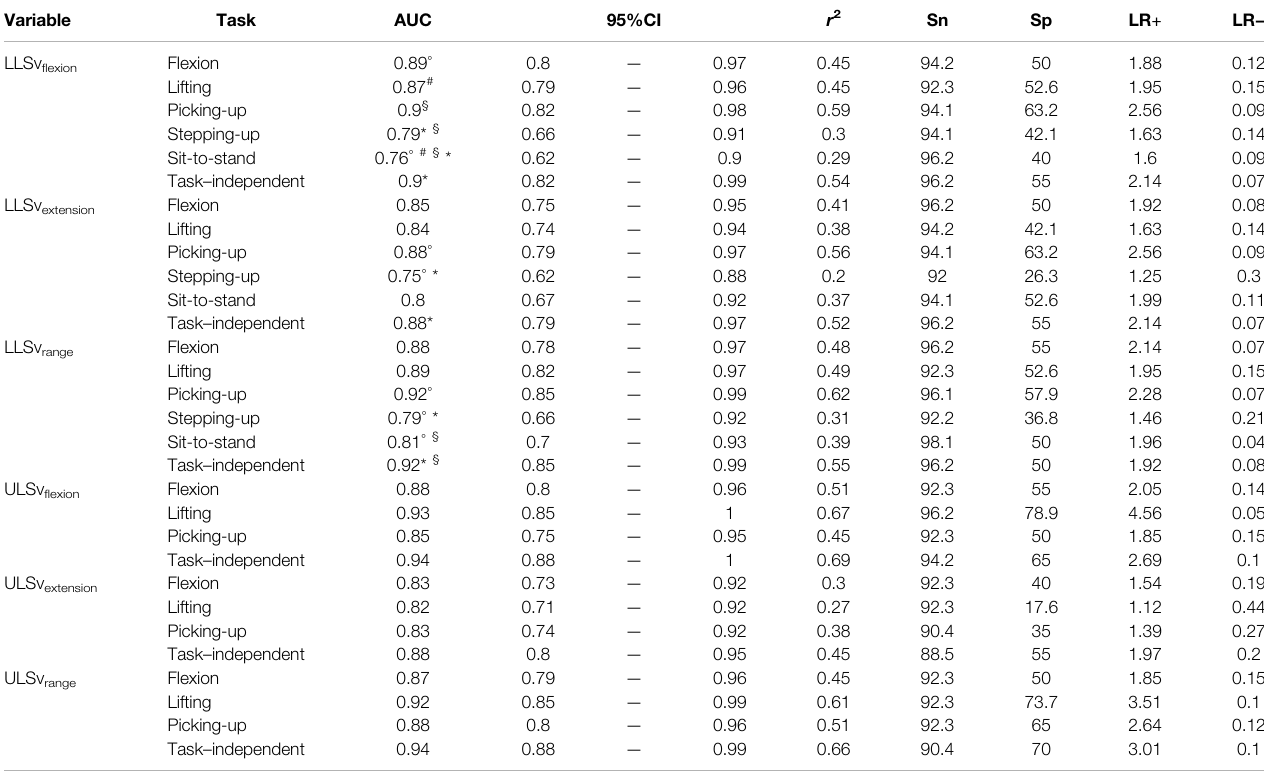
TABLE 3 | Logistic regression models for angular velocity measures. AUC: area under the curve [with its con fi dence interval (95%CI)]; r 2 : coef fi cient of determination; Sn: sensitivity;Sp:speci fi city;LR+:positivelikelihoodratio;LR − :negativelikelihoodratio.Symbols( ° ,§,#, *)indicateadifferenceofAUC > 0.1betweentwotasksorbetweena speci fi c-task and the task – independent